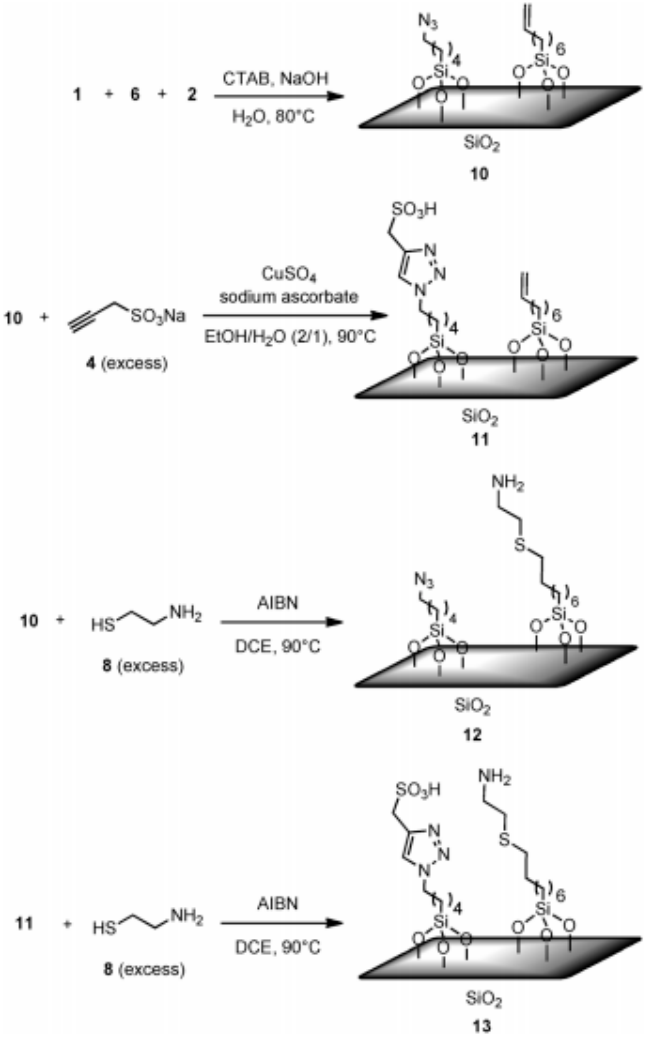
Figure 19. Preparation of bifunctional silica particles 13 . Reproduced with permission from [27].